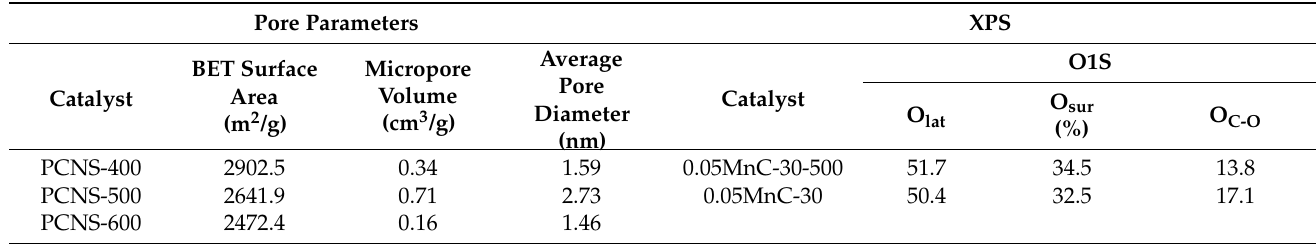
Table 1. Pore parameters of PCNS treated at different calcination temperature and XPS result of O1s for 0.05MnC-30-500 and 0.05MnC-30.